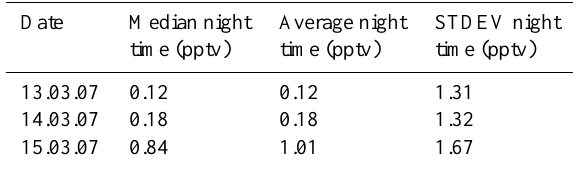
Table 2. Observed night time NO during pristine background con- ditions.